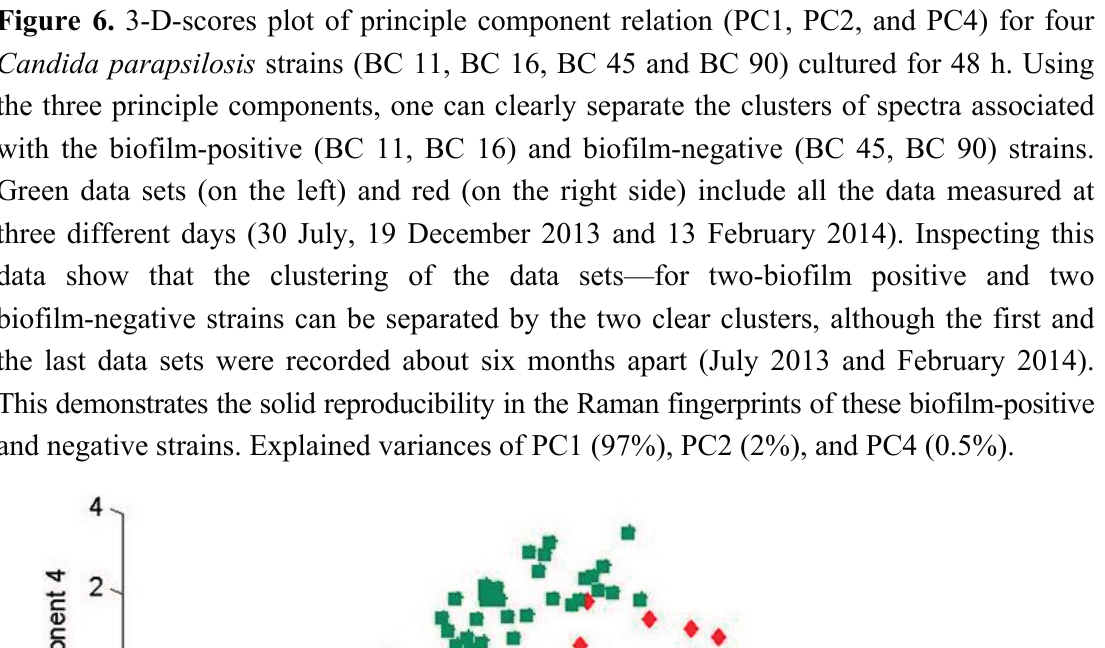
Figure 6. 3-D-scores plot of principle component relation (PC1, PC2, and PC4) for four Candida parapsilosis strains (BC 11, BC 16, BC 45 and BC 90) cultured for 48 h. Using